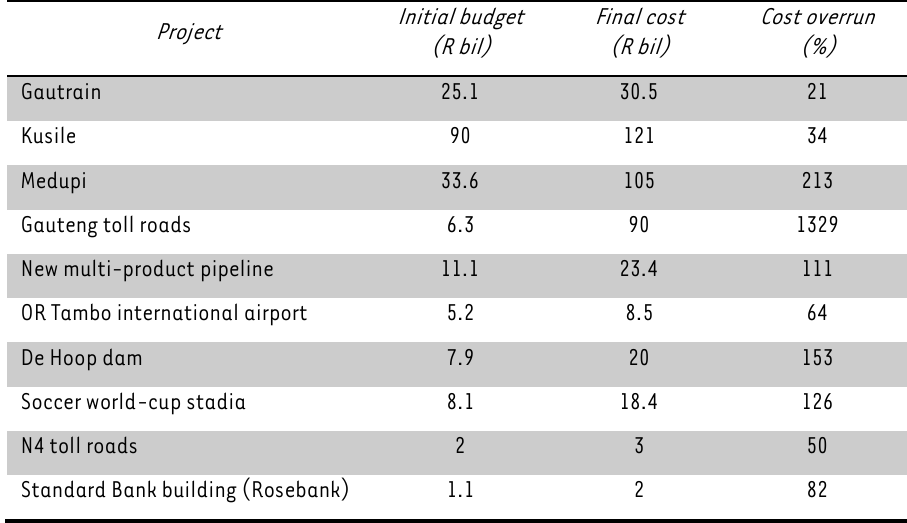
TABLE 7: Project overruns in South